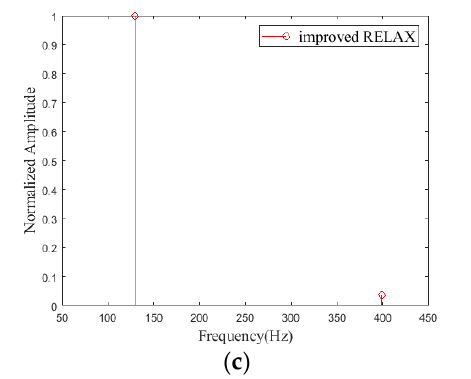
RELAX algorithm 130 Hz and 400 Hz.